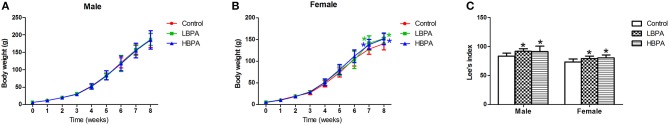
Effects of perinatal exposure to BPA on body weight and Lee's index of offspring. (A,B) Effects of perinatal exposure to BPA on body weight of offspring. (C) Perinatal exposure to BPA increased Lee's index of offspring. Data are expressed as means ± SD, n = 12. Statistical significance was determined by one-way ANOVA. *p < 0.05 compared to control group. LBPA, 1 μg/ml BPA; HBPA, 10 μg/ml BPA.